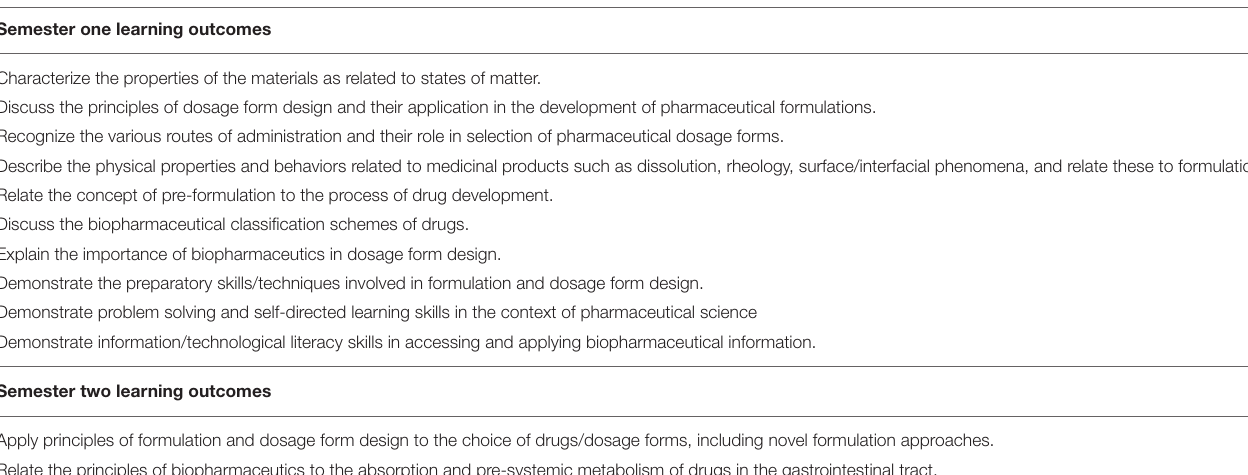
TABLE 1 | Learning outcomes for the first and second semester pharmaceutical science components of the BPharm in Part II. Semester one learning